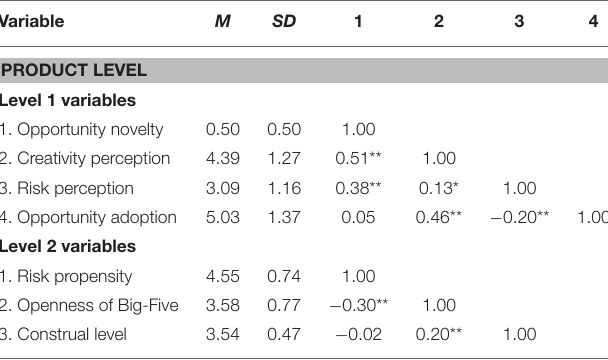
TABLE 1 | Descriptive statistics and correlations among all variables.